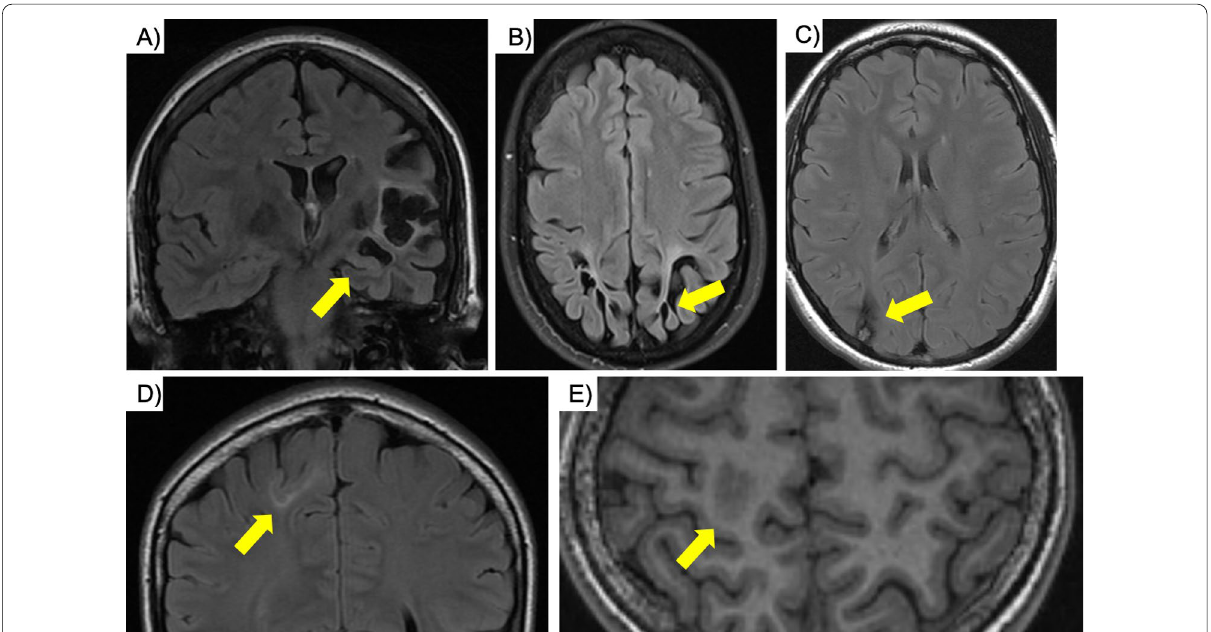
Fig. 4 Extratemporal findings: a Chronic left MCA infarct with concomitant left MTS (arrow, dual pathology). b Adult patient with birth-related findings of biparietal thinning of the white and gray matter with associated gliosis and ulegyria (arrow). c Cortically based, right parietal cavernoma with associated hemosiderin staining of the white matter. d and e (same patient) Focal cortical dysplasia with cortical thickening, blurring and FLAIR Hyperintensity of the gray-white matter junction